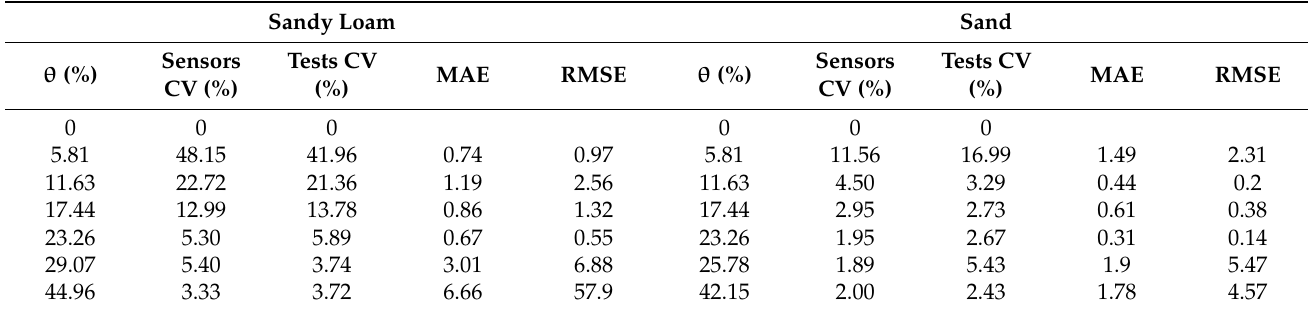
Figure 7. FDR soil moisture sensors: ( a ) calibration curves and ( b ) R 2 validation results in comparison to real values. Table 3. Coefficient of variation for the soil moisture